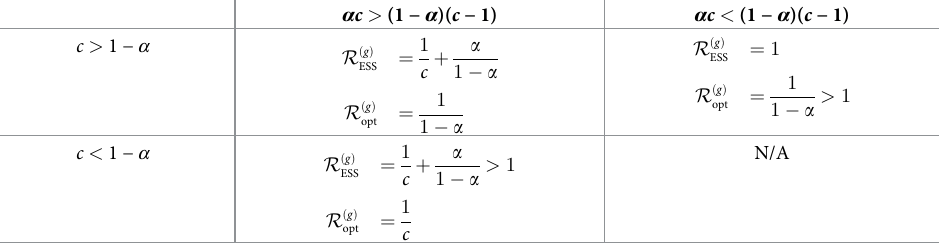
Table 1. Evolutionarily-stable and socially-optimal sociality strategies R ð g Þ tive values of the relative weight α of the good contagion under Cobb-Douglas utility and the relative infectious- ness c of the bad